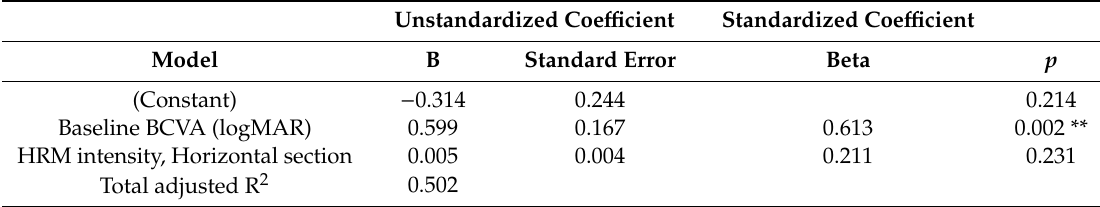
Table 4. Multivariate linear regression analysis for BCVA at month